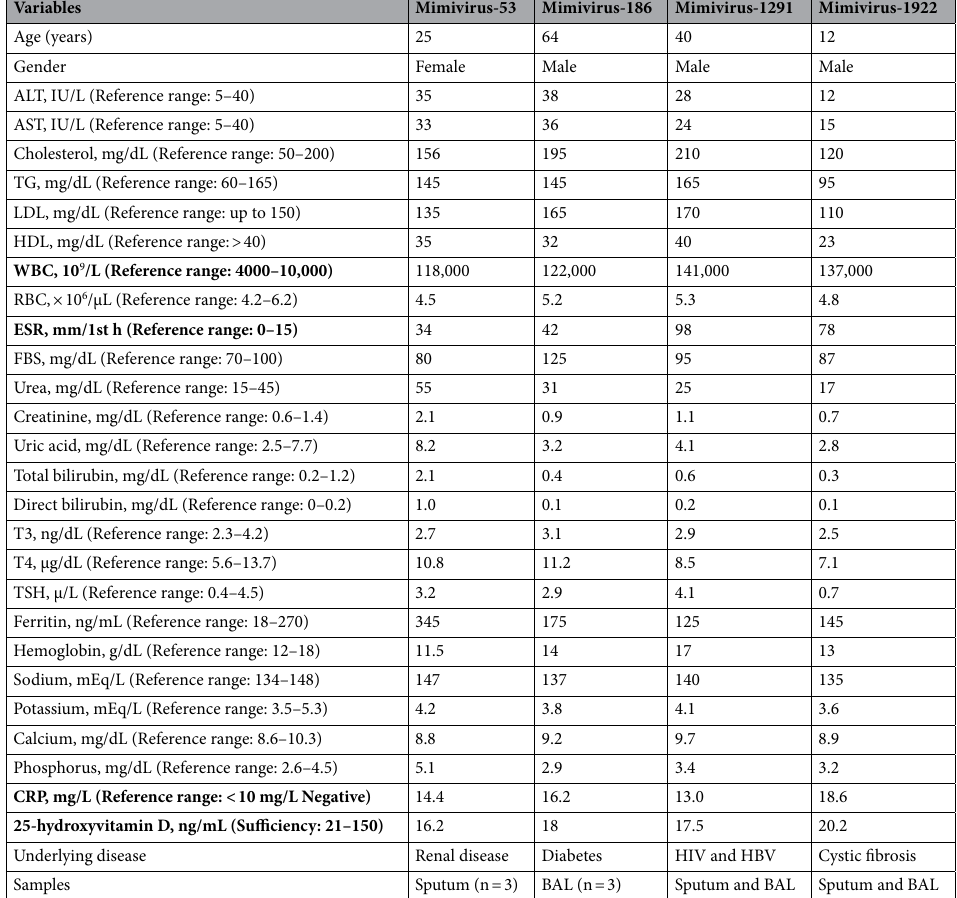
Table 1. Comparison laboratory parameters between all isolated Mimiviruses. ALT alanine aminotransferase, AST aspartate aminotransferase, ALP alkaline phosphatase, TG triglyceride, LDL low density lipoprotein,